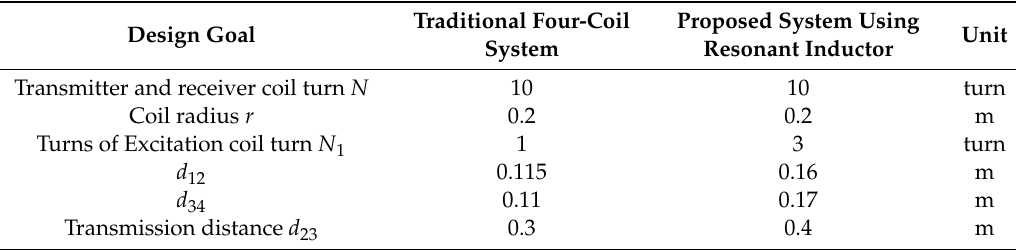
Table 5. Coil parameters of the two types of WPT